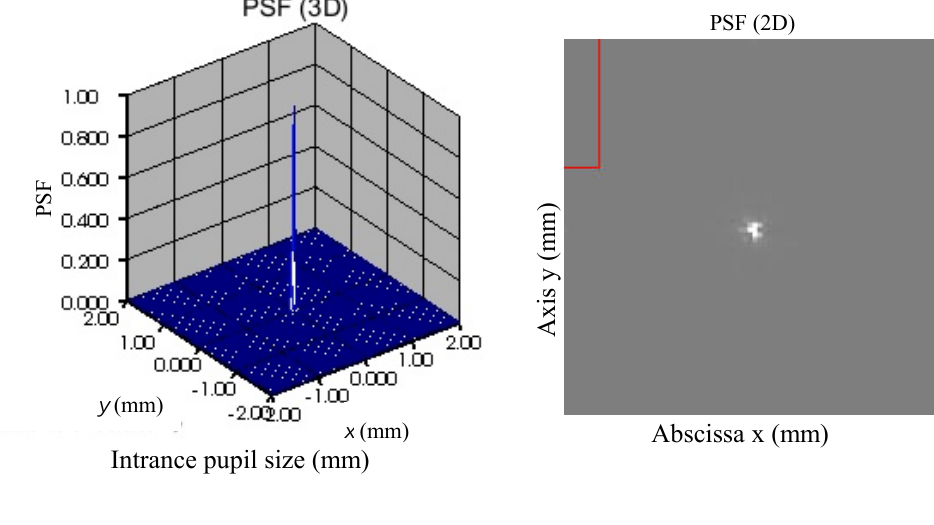
Figure 8. PSF of the corrected